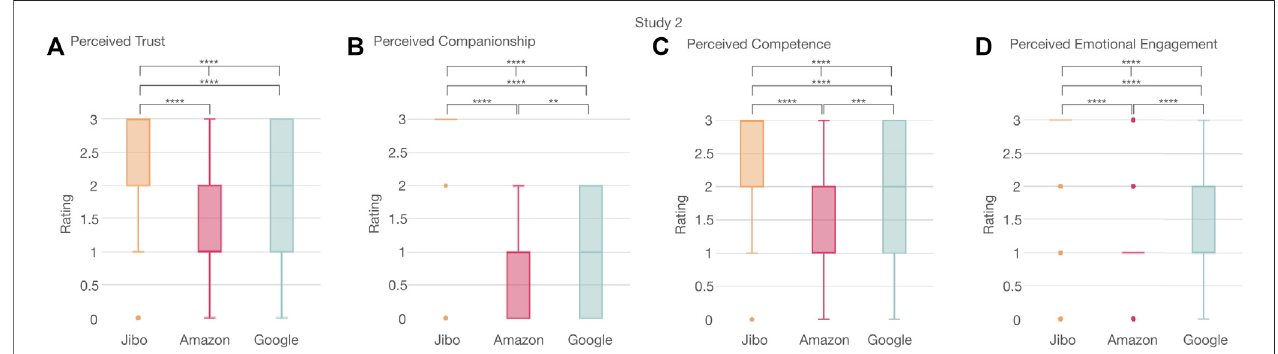
FIGURE9 | Signi fi canttrend in perceived trust, companionship,competence, and emotional engagement ofvoice agents between participants showing Jibowas signi fi cantly perceived as (A) more trustworthy, (B) more like a companion, (C) more competent, and (D) more emotionally engaging than Amazon or Google. Google was perceived as (B) more like a companion, (C) more competent, and (D) more emotional engaging than